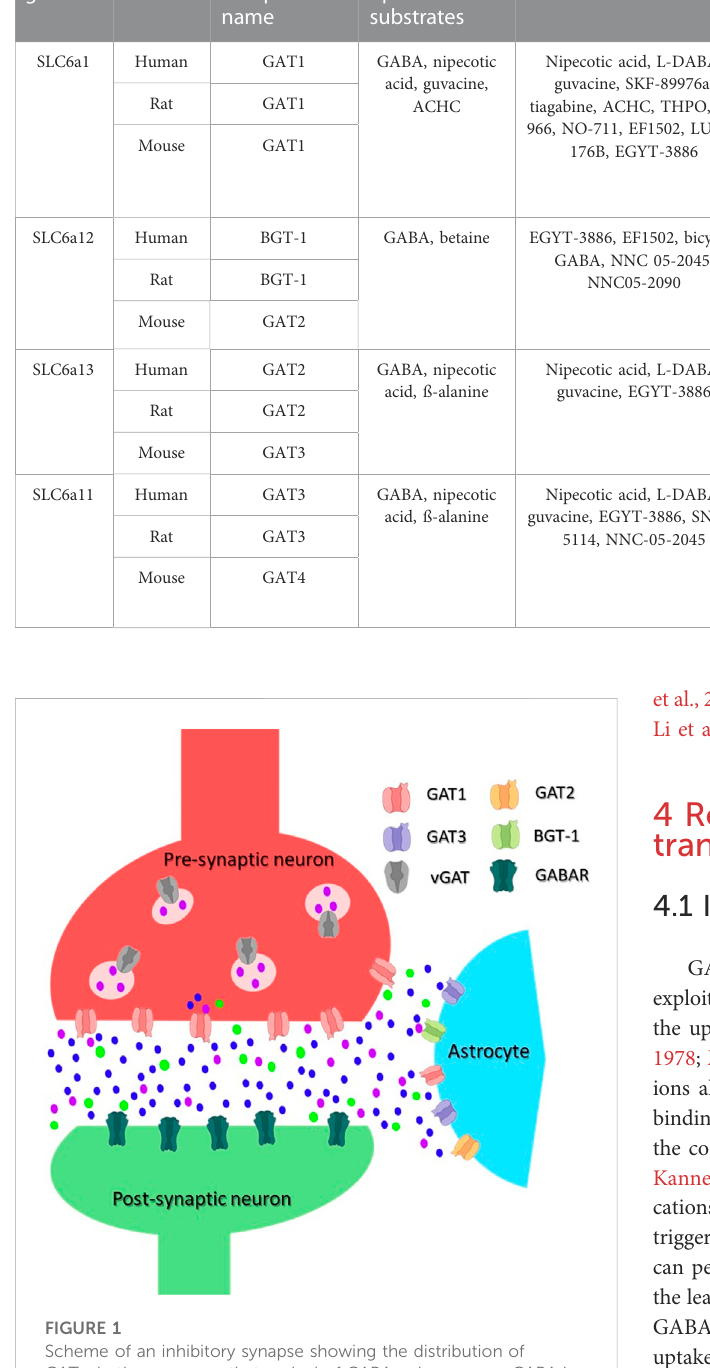
TABLE 1 Nomenclature, uptake substrates, inhibitors, and tissue expression of GABA transporters. SLC6 gene